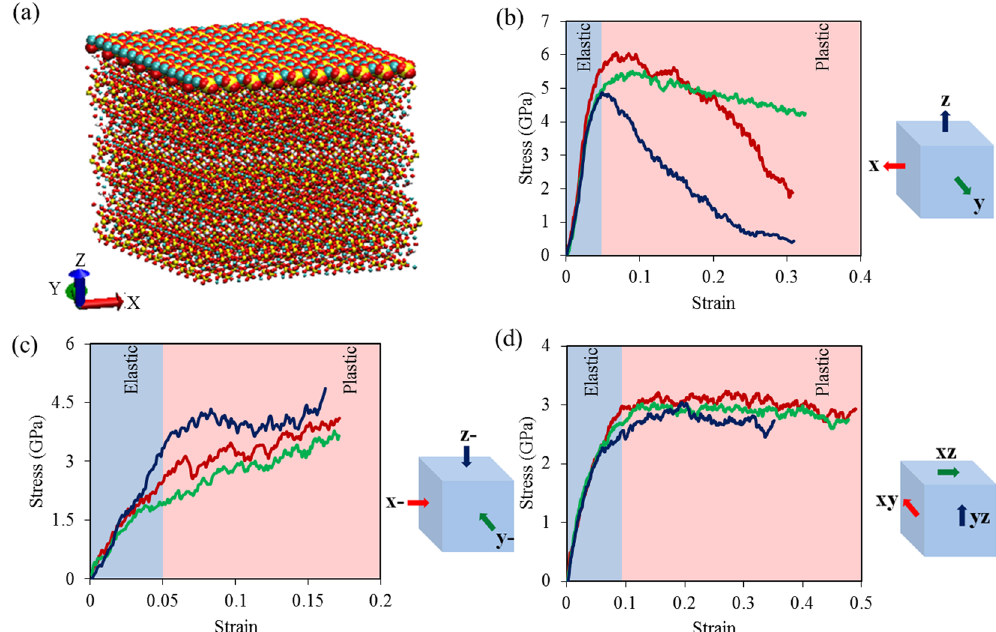
Figure 2. ( a ) The tobermerite super cell highlighting the top calcium-silicate layer. ( b ) Stress-Strain curves for tension along x, y, and z axis, which are illustrated by the red, green, and blue curves, respectively. ( c ) Stress-Strain curves for compression along x, y, and z, which are illustrated by the red, green, and blue curves, respectively. ( d ) Stress-Strain curves for shear in xy, xz and yz plane, which are illustrated by the red, green, and blue curves, respectively. The blue region is the elastic stage, while the red region is the plastic-damage stage.